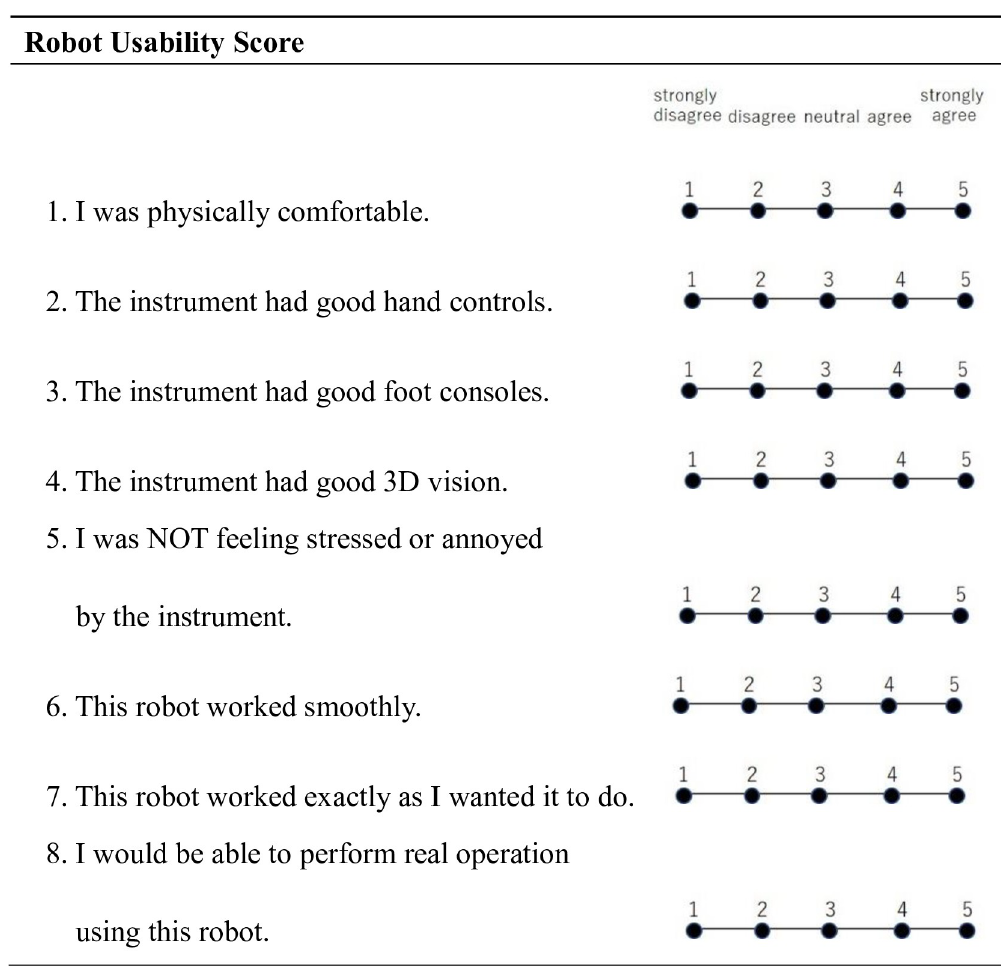
Fig 4. Robot Usability